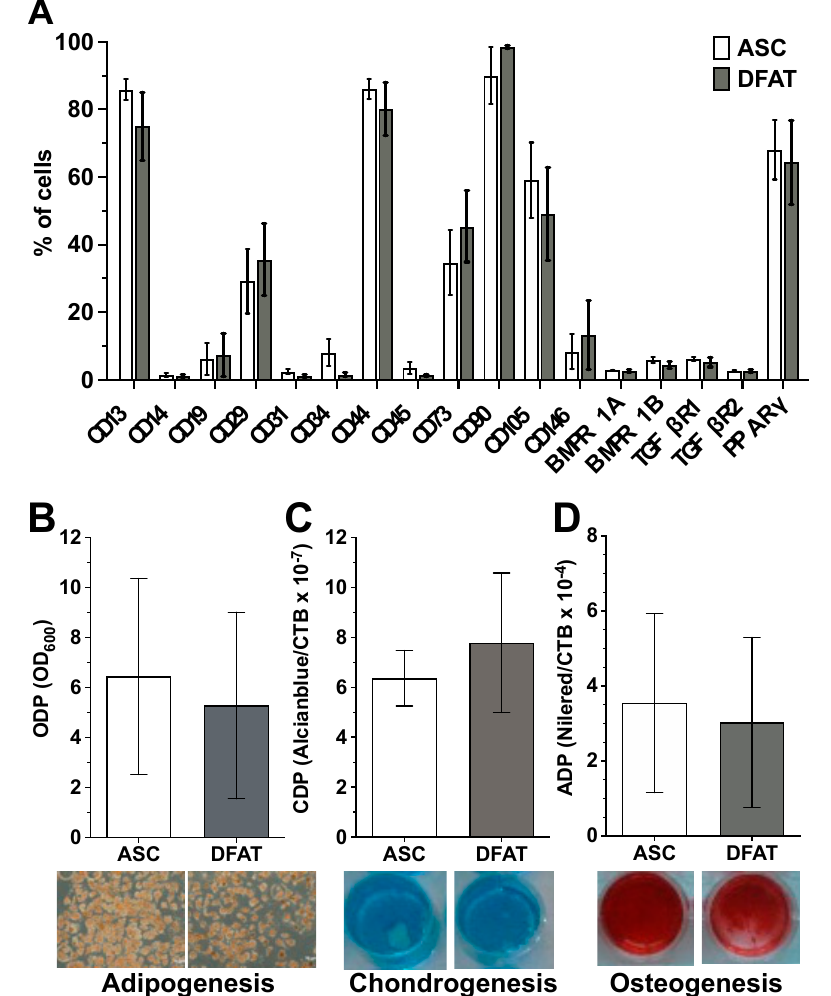
Figure 1. Mesenchymal stem cell character of the established ASC and DFAT cultures obtained from the same adipose tissue sample. ( A ) Flow cytometry-based characterization of the surface antigen phenotype of ASCs and their corresponding DFATs in passage 2. CD146 and BMPs and TGFs are n = 6, CD14 and 34 are n = 8, all remaining CDs are n = 11. PPARy n = 3. ( B – D ), Evidence of plastic adherence and multilineage differentiation potential of ASC and DFAT cultures obtained from the same adipose tissue: adipogenic ( B ), chondrogenic ( C ), osteogenic ( D ) differentiation potential, scale bar 200µM. Adipo- (at day 21, n = 6), Chondrogenesis (at day 24, n = 6), Osteogenesis n = 15 (at day 14, including 6 additional donors’ data), paired t -test and mean + SD.